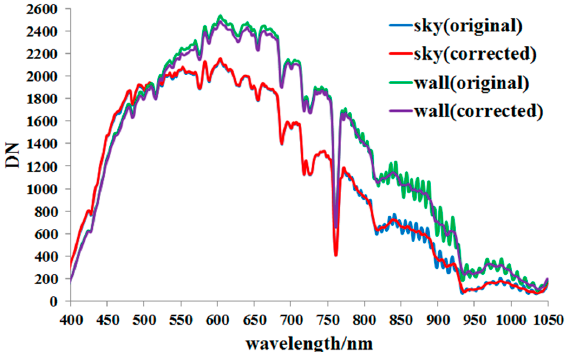
Figure 19. Correction results of the ground data using the proposed method. ( a ) RGB image in visible bands (R: 650 nm, G: 560 nm, B: 480 nm); ( b ) False-color RGB image in NIR bands (R: 800 nm, G: 890 nm, B: 960 nm). Remote Sens. 2018 , 10 , 79